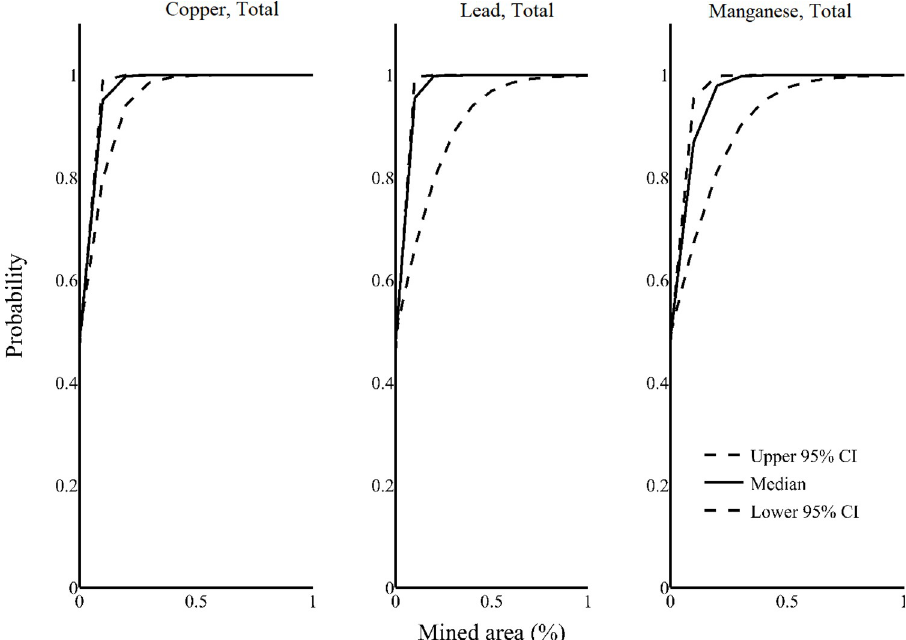
Fig 3. Increases in the proportion of drainage basins that were mined increased the probability that chronic exposure toxicity thresholds would be exceeded for three water quality measures. Graphs show the change in probability of exceedance per change in mined area as estimated by linear mixed models. Dashed lines encompass the 95% credible interval around estimated